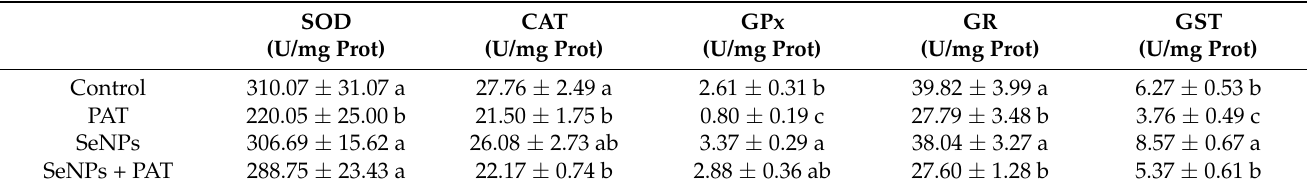
Figure 6. The effect of SeNPs on oxidative stress indicators in liver and kidney of mice, including ( a ) GSH, ( b ) GSSG, ( c ) GSH/GSSG, ( d ) MDA and ( e ) PC levels, as well as ( f ) serum LPS levels. The results are expressed as means ± SD. The different lowercase letters in the same color indicate significance ( p < 0.05) of values. Table 2. Effect of SeNPs on SOD, CAT, GPx, GR and GST activities in liver of PAT-treated mice *.